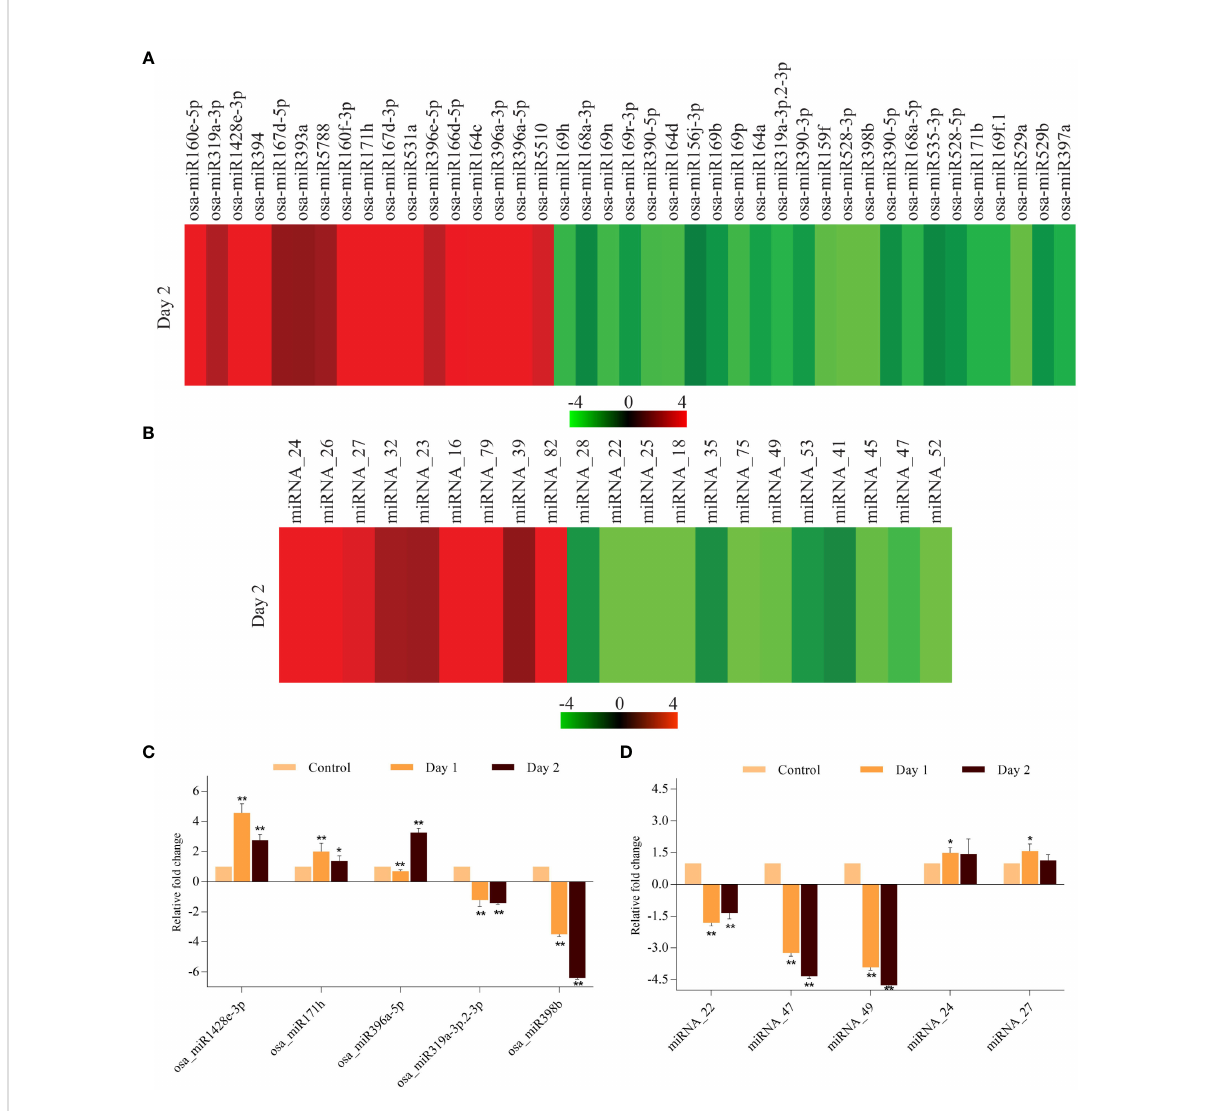
FIGURE 6 Expression pro fi ling of miRNAs that are differentially expressed during coleoptile senescence in rice. Heat map of differentially expressed miRNAs belonging to ‘ conserved miRNAs ’ (A) and ‘ novel miRNAs ’ (B) categories during coleoptile senescence in rice. Quantitative PCR-based validation of few conserved (C) and novel (D) miRNAs. For normalization, 5S ribosomal RNA was used as internal control. Three biological replicates and two technical replicates were included in the study. Asterisks indicate signi fi cant differences between the control and